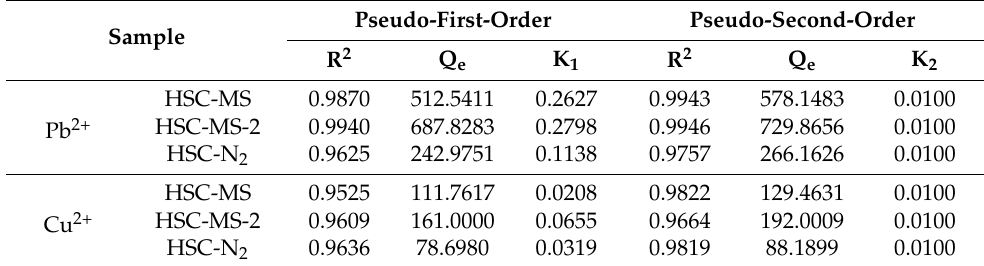
Figure 7. ( a , b ) Adsorption kinetics of Pb 2+ on HSC-MA-2, HSC-M and HSC-N 2 (linear plot of pseudo-first-order and pseudo-second-order rate equation); ( d , e ) adsorption kinetics of Cu 2+ on HSC-MA-2, HSC-M and HSC-N 2 ; intra-particle diffusion model for ( c ) Pb 2+ and ( f ) Cu 2+ . Table 4. Kinetic parameters of Pb 2+ and Cu 2+ on HSC-N 2 , HSC-M and HSC-MA-2.